Question: What does this figure show? Answer in one sentence.
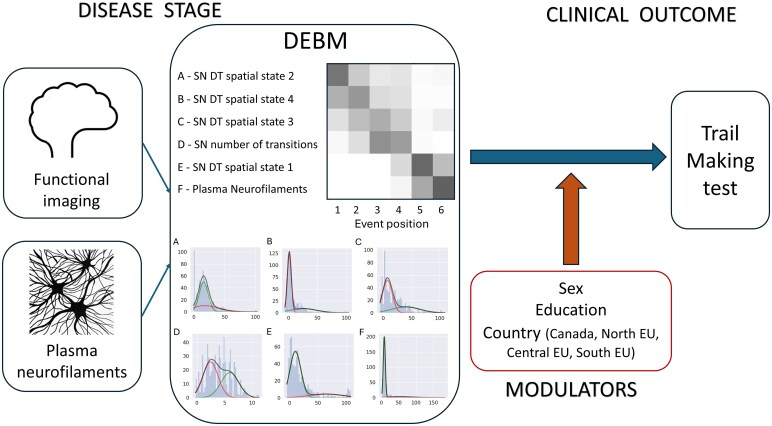
Answer: Study design. DEBM = Discriminative Event-Based Model; DT = Dwell Time; EU = European Union; SN = Salience Network. A data-driven Discriminative Event-Based Model that allows for patient staging was assessed through resting state functional imaging measures and plasma neurofilament levels. Clinical performances were evaluated by Trail Making Test part A (TMT A) and part B (TMT B). Sex, educational level and country of residence were examined as potential modulators of the relationship between disease stage and clinical performances.